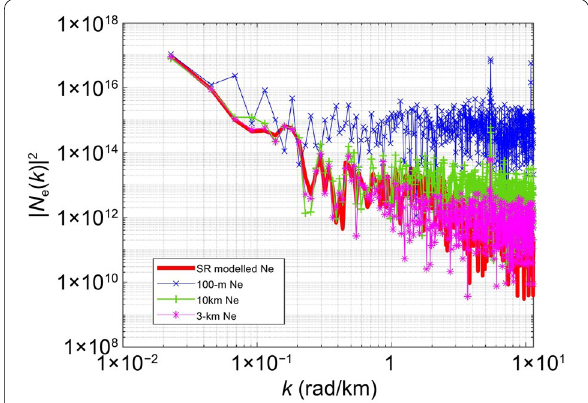
Fig. 14 Wavenumber spectrum comparison between different vertical separations. (Adapted from Peng and Scales (2019))